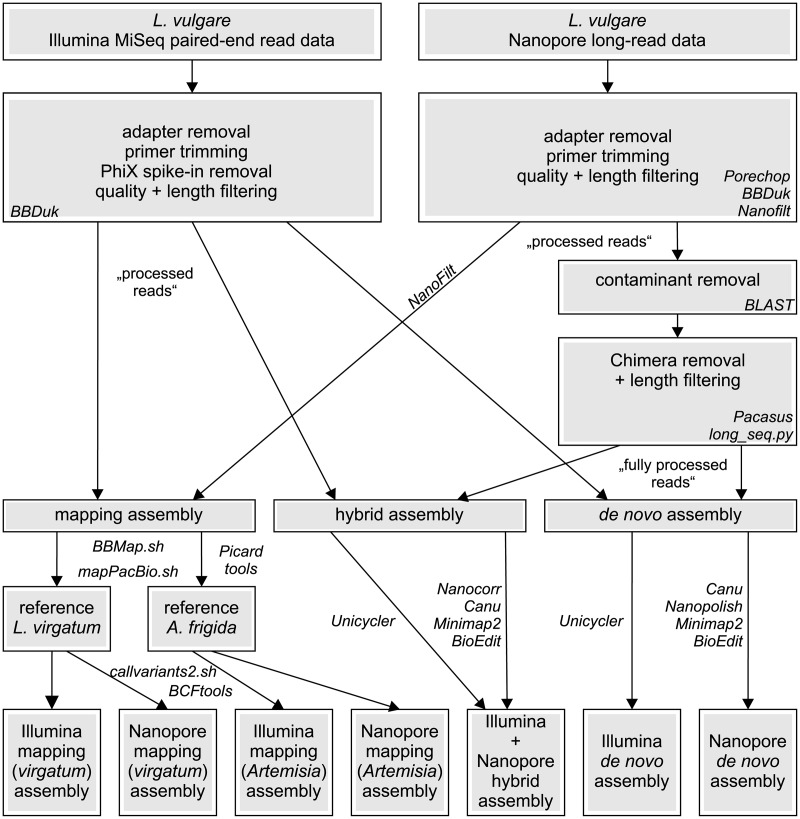
Schematic bioinformatic workflow for comparative assembly of chloroplast genomes.Tools used for each processing step are given in italics. Leucanthemum virgatum was assembled de novo with Illumina data and subsequently used as reference for mapping.